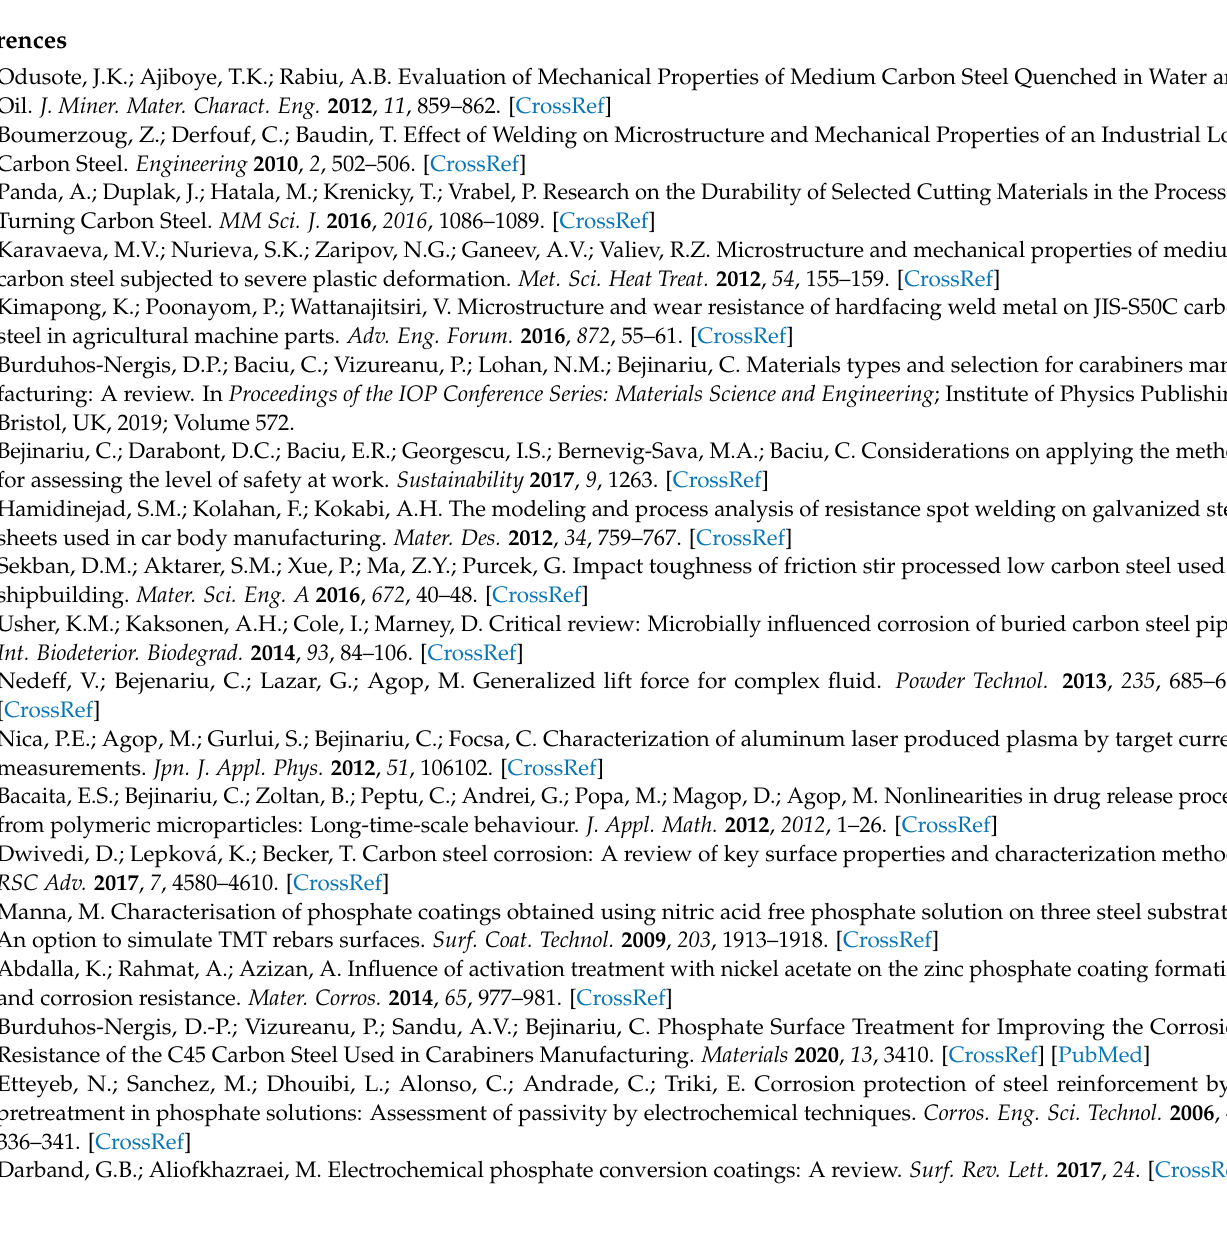
Figure A6. The Nyquist diagram ( a ) and Bode diagram ( b ) for PPS sample after 78 days of immersion in BSW.